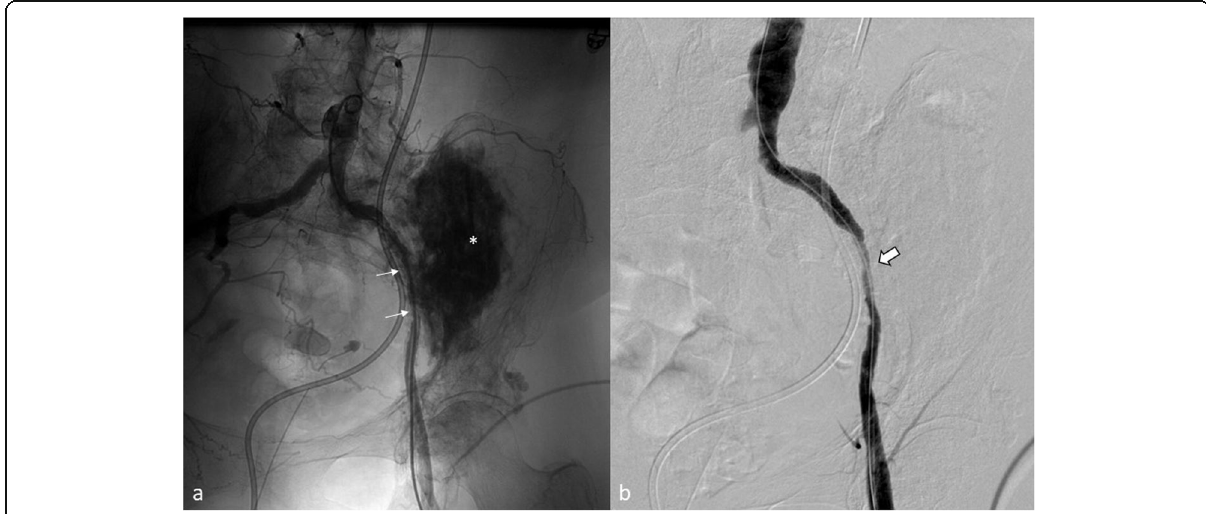
Fig. 2 Case #3: 81-year-old woman with left sided bleeding from UAF. Angiogram shows the ureteric stent in direct proximity of the left CIA and EIA with closed IIA while there is no direct proof of the fistula on angiography. Massive calcified bone metastasis (*) compresses the left iliac arteries (small arrows) ( a ). The final control angiogram shows the crossing of the common iliac artery and the ureteric stent covered by a stent graft. Metastatic compression led to a not fully unfolded stent graft (large arrow) ( b